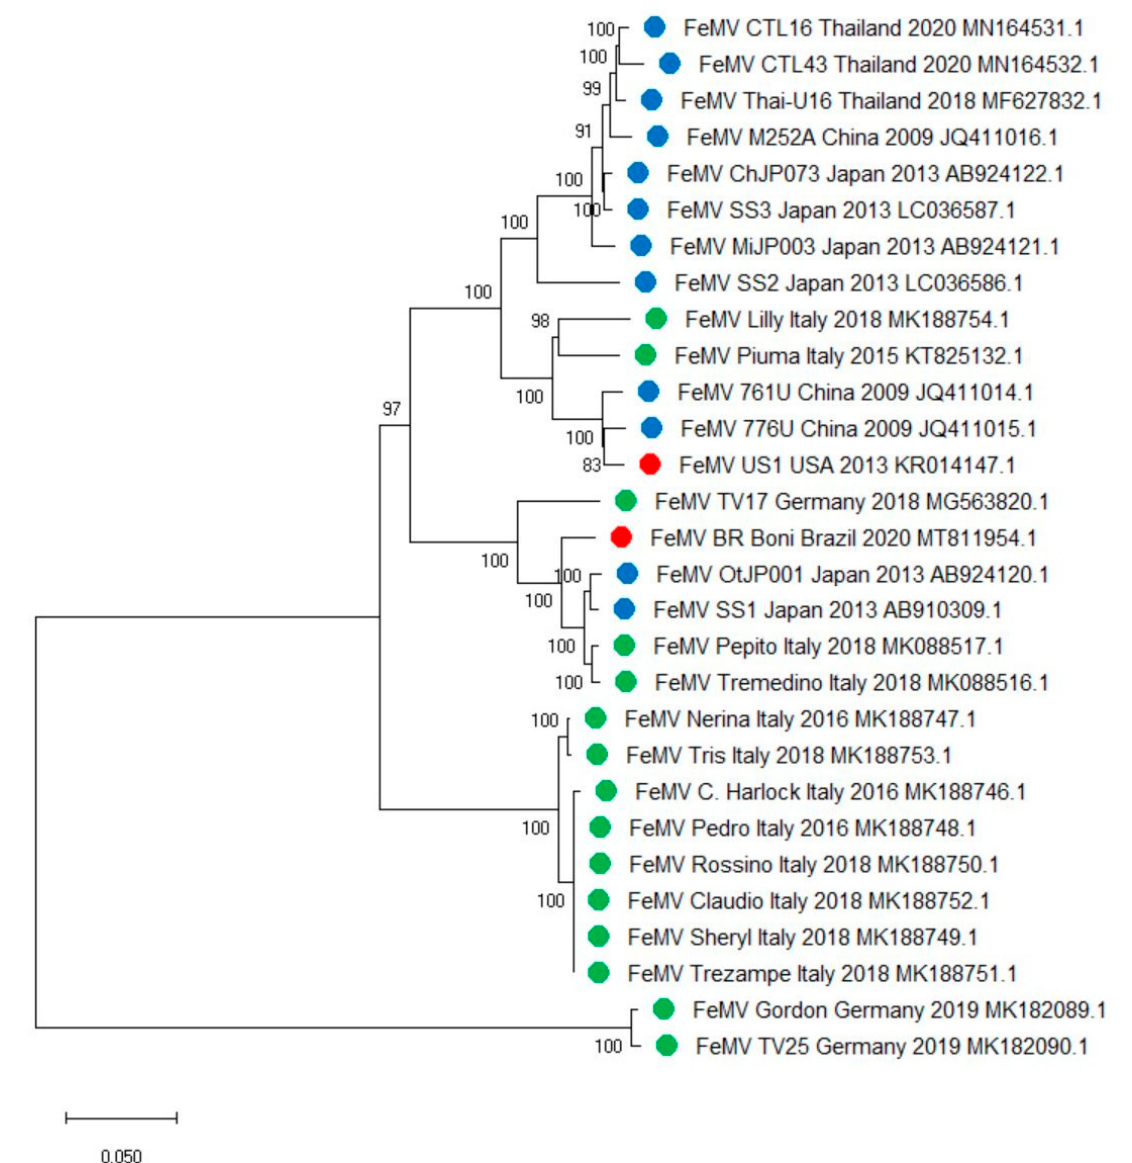
Figure 1. Phylogenetic analysis based on publicly available feline morbillivirus (FeMV) full-genome sequences. The tree with the highest log likelihood ( − 73307.55) is shown. The percentage of trees in which the associated taxa clustered together is shown next to the branches. The evolutionary history was inferred by using the Maximum Likelihood method and General Time Reversible model [43]. Initial tree(s) for the heuristic search were obtained automatically by applying Neighbor-Join and BioNJ algorithms to a matrix of pairwise distances estimated using the Maximum Composite Likelihood (MCL) approach and then selecting the topology with superior log likelihood value. A discrete Gamma distribution was used to model evolutionary rate differences among sites (five categories (+G, parameter = 0.5429)). The rate variation model allowed for some sites to be evolutionarily invariable ([+I], 30.85% sites). The tree is drawn to scale, with branch lengths measured in the number of substitutions per site. This analysis involved 29 nucleotide sequences. There was a total of 16,001 positions in the final dataset. Evolutionary analyses were conducted using MEGA X [44]. Legend: blue, FeMVs identified in Asia; green, FeMVs identified in Europe; red, FeMVs identified in